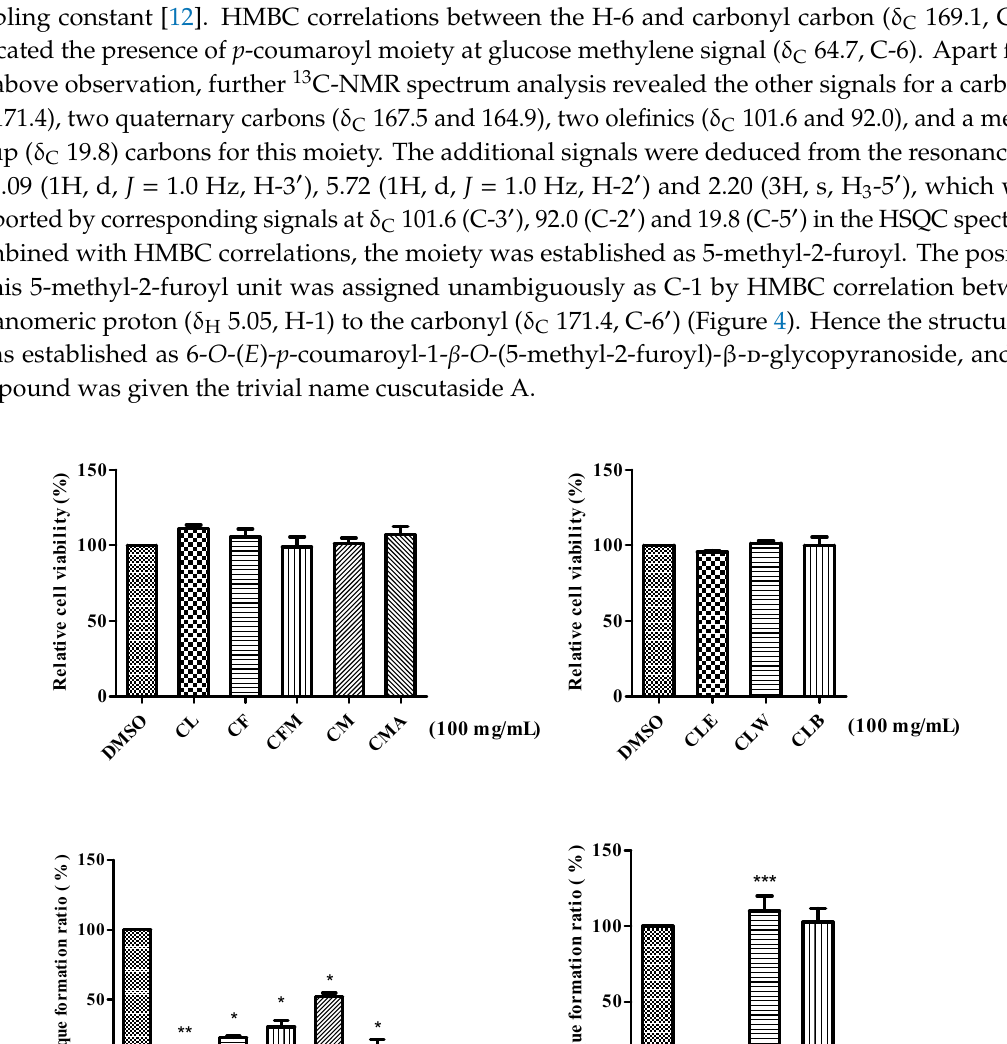
Figure 3. Chemical structures of compounds 1 – 4 . 2.1. Structural Elucidation of New Compounds